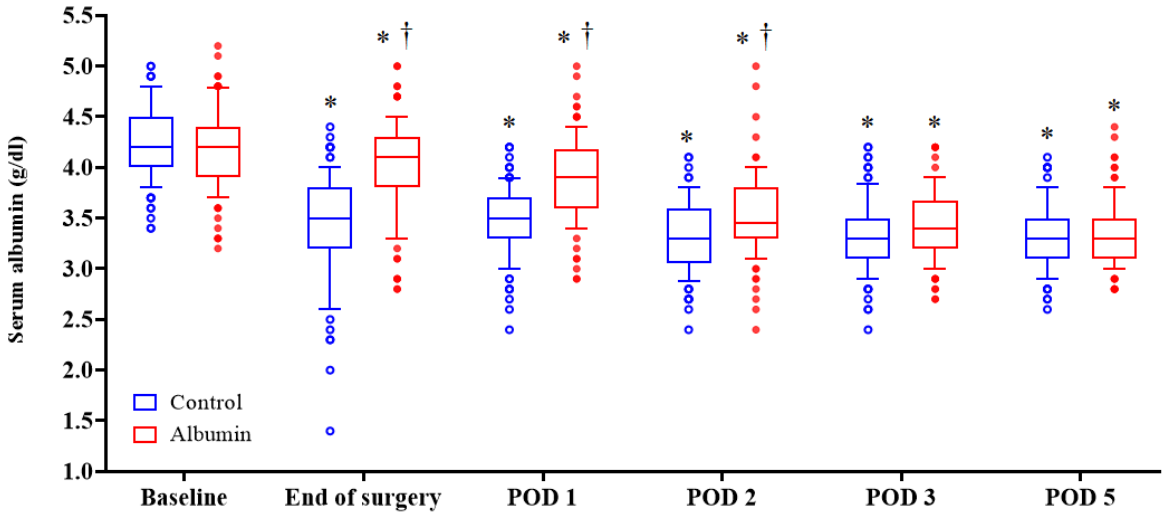
Figure 3. Postoperative changes of serum albumin levels in both groups. Horizontal lines, boxes, and error bars represent the median, interquartile range, and outliers, respectively. * p < 0.05 versus baseline value. † p < 0.05 versus control group. All p values were adjusted by Bonferroni correction. POD: postoperative day.